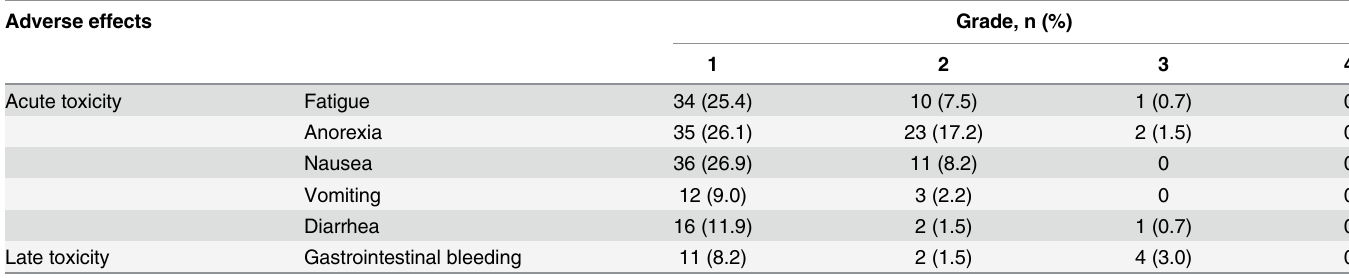
Table 4. Adverse effects after